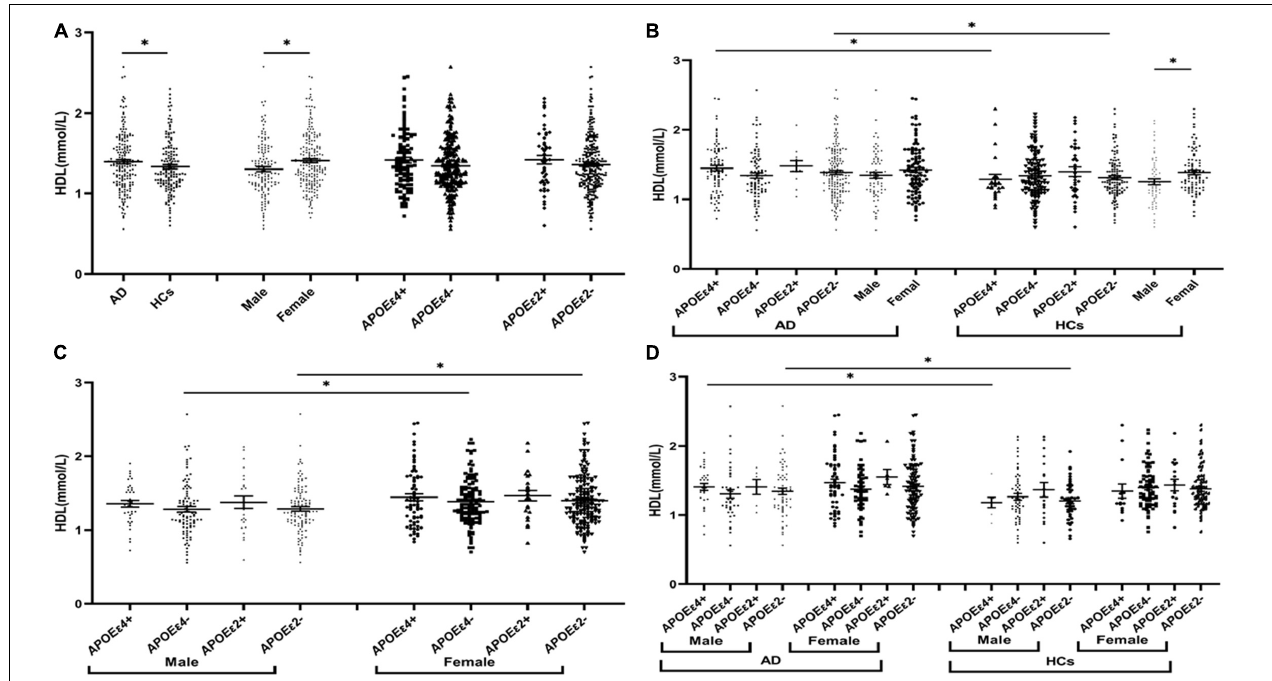
FIGURE 3 | The levels of LDL in different populations. ∗ P < 0.05; Values are expressed as mean (standard error). AD, Alzheimer’s disease; HCs, healthy controls; APOE ε 4 +, APOE ε 4 carriers; APOE ε 2 +, APOE ε 2 carriers.